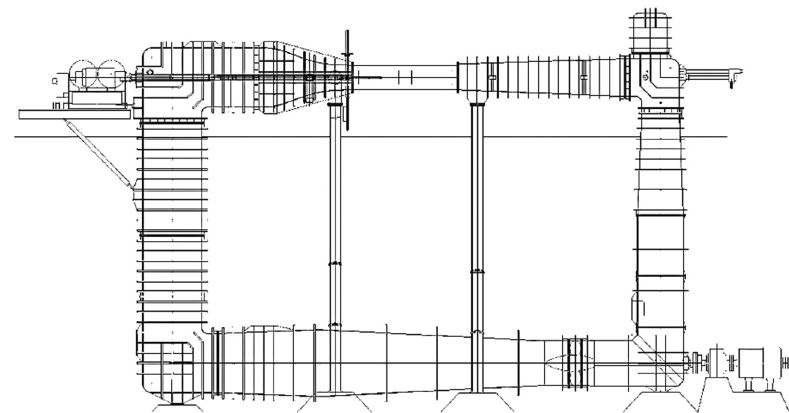
Figure 6: Cavitation tunnel in the potsdam cavitation test [ 43 ]